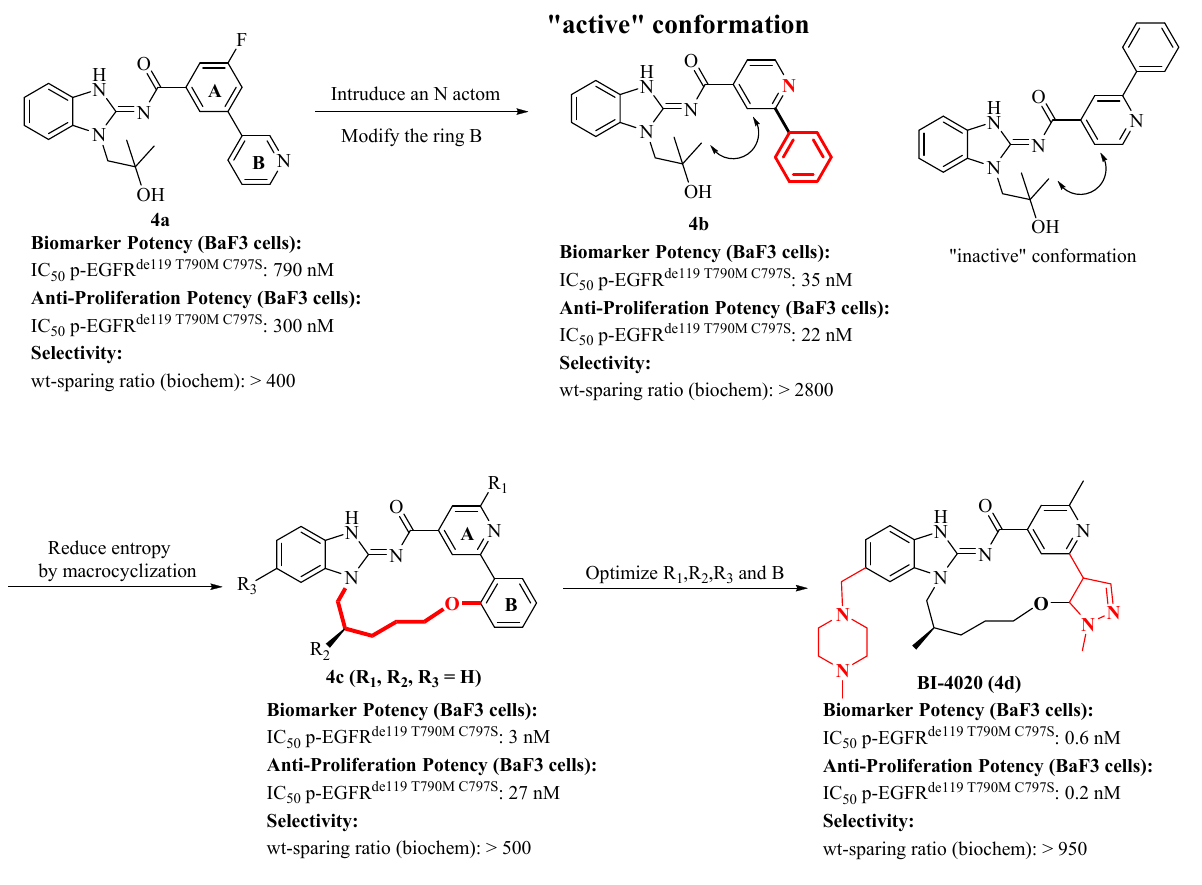
Figure 7. ( A ) X-ray structure of 4b (PDB: 6S9C) in complex with EGFR L858R T790M . ( B ) Overlay of X- ray-based structure of compound 4b (cyan) and X-ray structure of compound 4c (orange, PDB: 6S9D) in complex with EGFR L85R T790M .